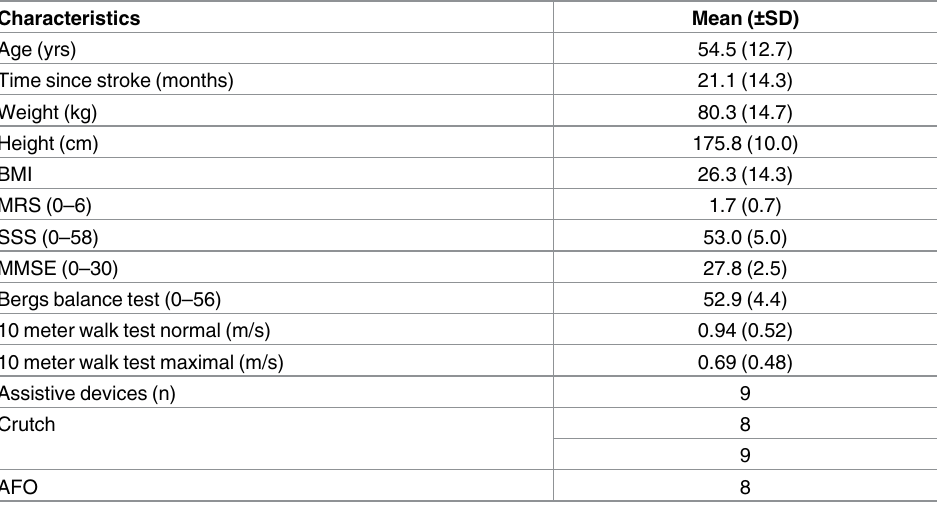
Table 1. Participant’s characteristics at inclusion (n = 31).